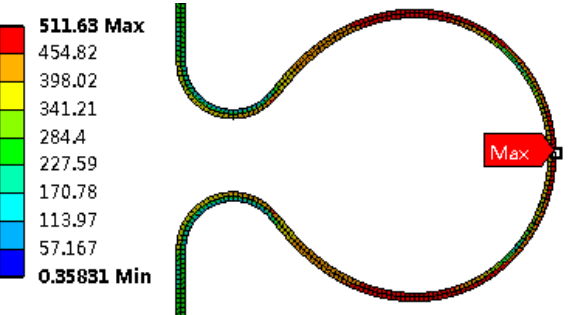
Figure 8. Von Mises equivalent stress distribution before unloading (MPa).